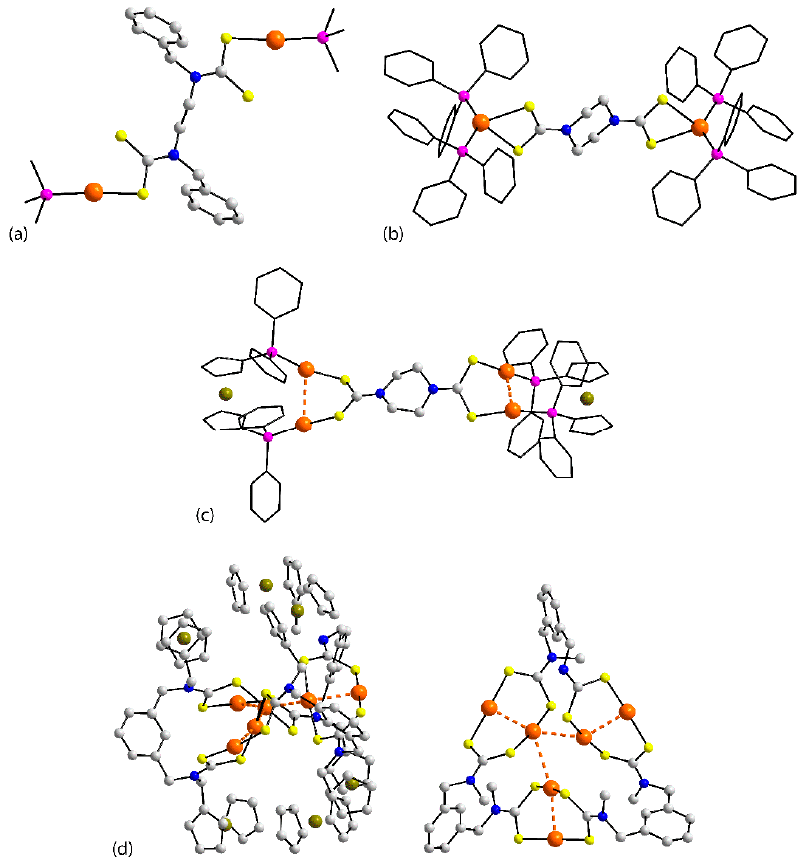
Figure 7. Molecular structures of ( a ) di-nuclear (Me 3 PAu) 2 (L 1 ) in the crystal of 28 , ( b ) di-nuclear [(Ph 3 P) 2 Au] 2 (L 2 ) in 30 , ( c ) tetra-nuclear [(dppf)Au 2 ] 2 (L 2 ) in 31 , and ( d ) hexa-nuclear Au 6 (L 12 ) 3 in 32 , with a simplified version shown in the right-hand side image. When present, the orange dashed lines represent aurophilic (Au … Au) bonding interactions.